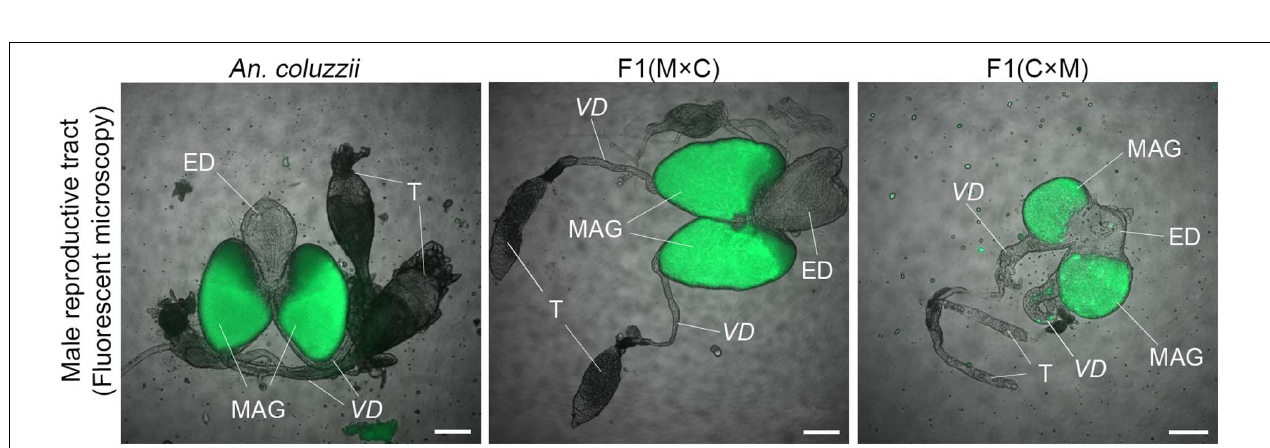
FIGURE 6 | Autofluorescent MAG-derived lipids in the male reproductive tract. MAG-derived lipids autofluoresce in MAGs of pure species and all hybrids as well as in vasa deferentia of hybrid males from